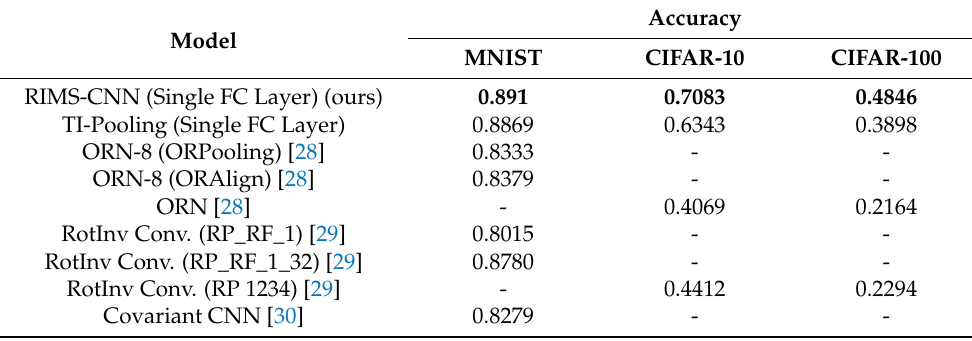
Figure 31. Evaluating RIMS-CNN and VGG-16 on the fixed-angle and random-angle rotated CIFAR-100. Table 7. Comparison of RIMS-CNN and some other rotation-invariant